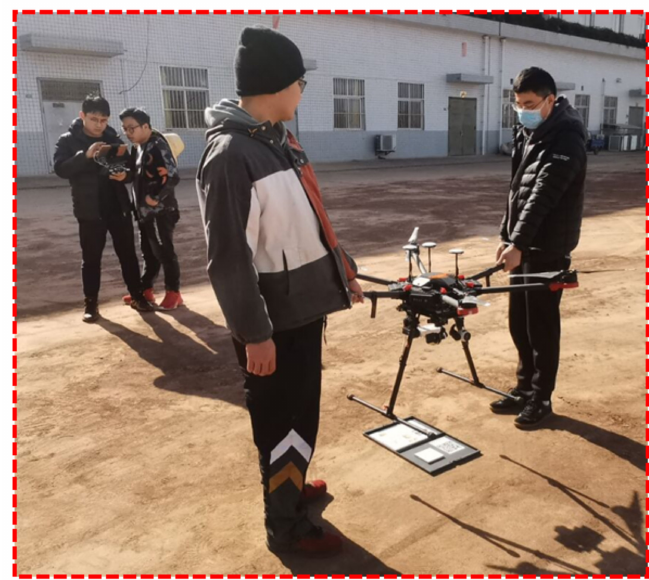
Figure 5. Multispectral camera radiometric calibration.